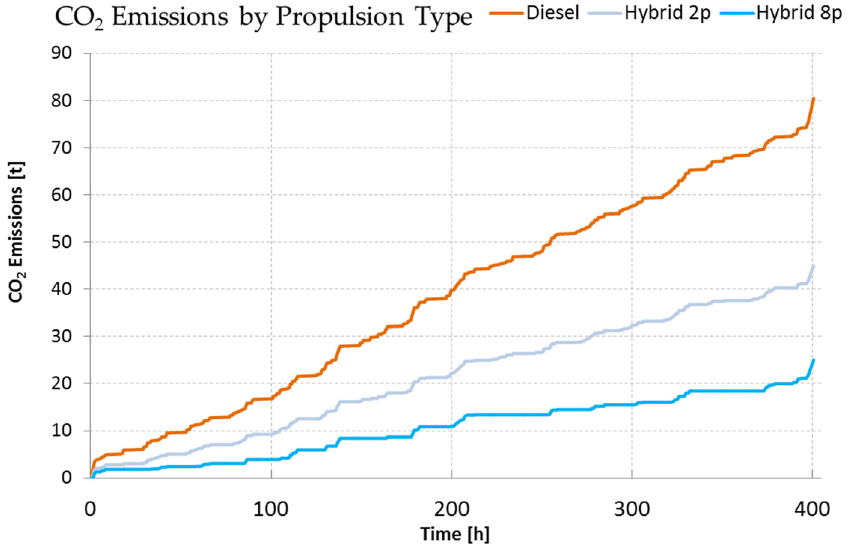
Figure 15. Plot of CO 2 emissions by propulsion type on the same test route.